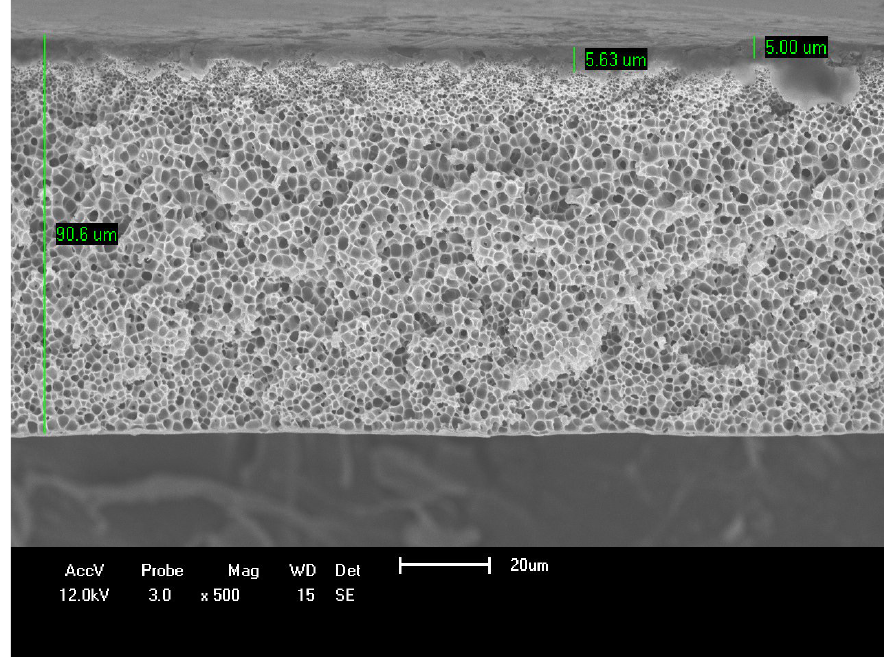
Figure 3 - Scanning electron micrograph of cross section